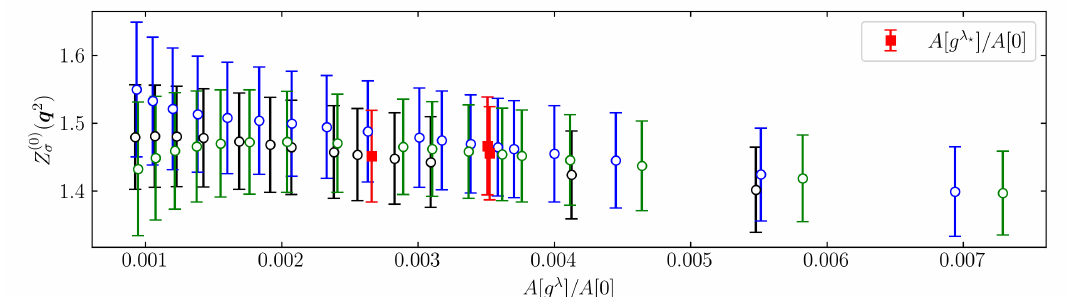
Figure 9 . Integral ¯ Z (0) σ ( q ) of the hadronic correlator with three kernels, plotted as a function of A [ g λ ] /A [0] . No significant difference is observed within the statistical errors for values A [ g λ ] /A [0] smaller than A [ g λ ? ] /A [0]